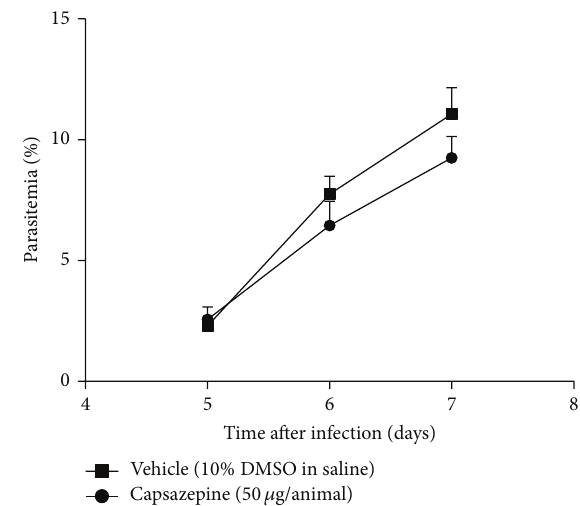
Figure 1: Effect of capsazepine on parasitaemia levels. Parasitaemia was measured daily, from day 5 to day 7 after infection in blood smear samples obtained from C57BL/6 mice infected with Plasmod- ium berghei ANKA (10 5 infected RBCs/animal; i.p.) treated with either capsazepine (50 𝜇 g/animal, 2x day, for 6 days) or vehicle (10% DMSO in saline) from 24 h after infection ( 𝑛 = 8 per